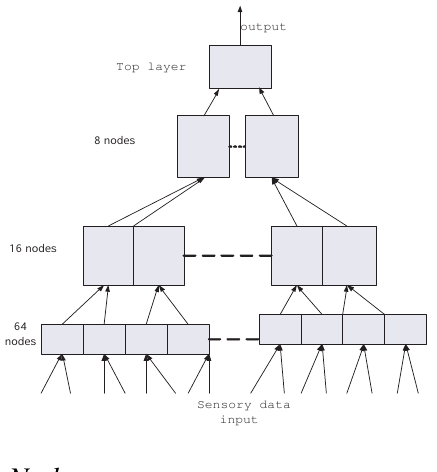
Figure 4. Our design for eating or drinking